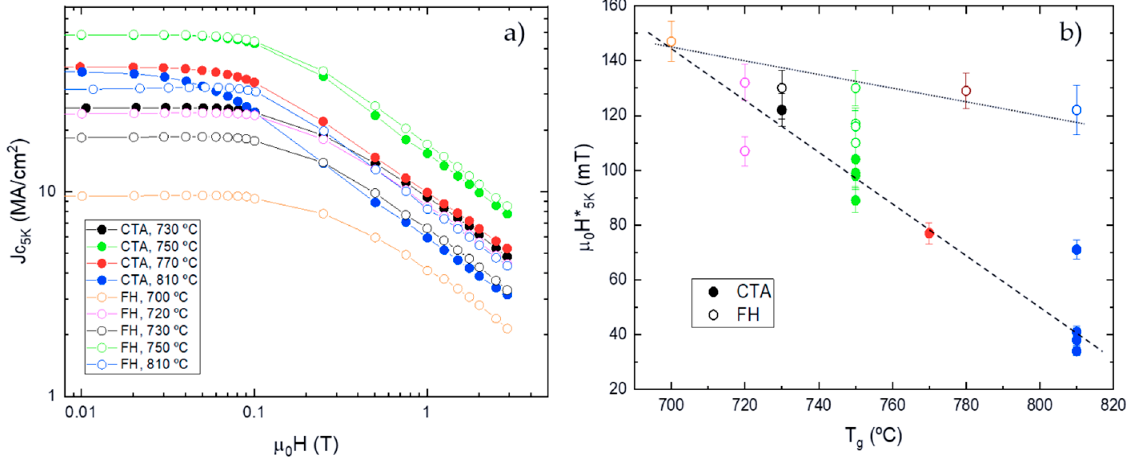
Figure 7. J c behavior with the magnetic field for samples grown with the CTA method (closed symbols) and the FH method (open symbols): ( a ) J c as a function of the magnetic field at different growth temperatures, ( b ) µ 0 H* values determined at 5 K as a function T g .